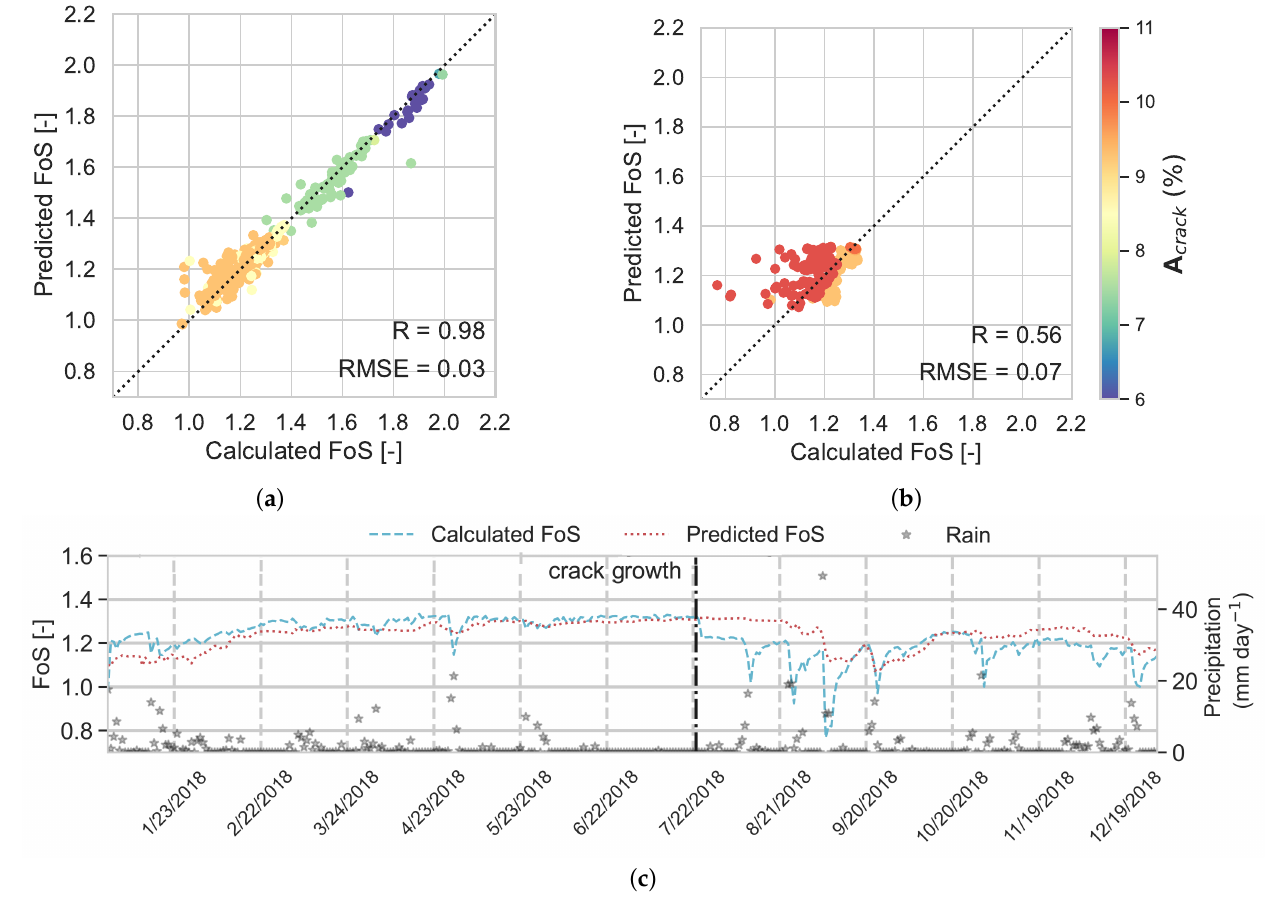
Figure 11. RF rta , Acr model performance, over ( a ) the testing data set and ( b ) the evaluation data set; and ( c ) time series of predicted and calculated FoS in the evaluation data set (year